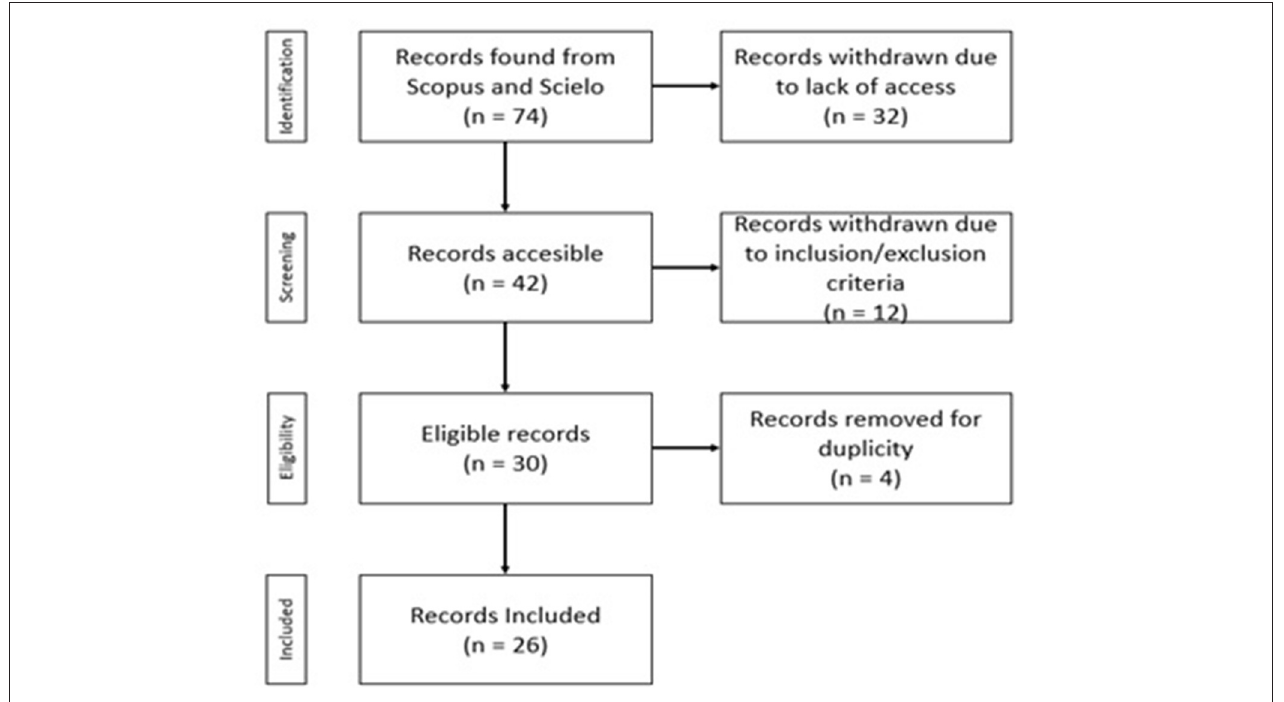
FIGURE 1 | PRISMA flow